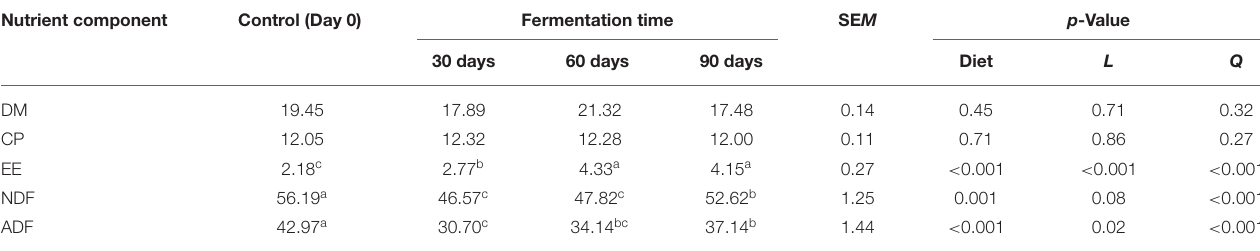
TABLE 6 | Effect of ensiling duration on the rape silage nutrient content. Nutrient component